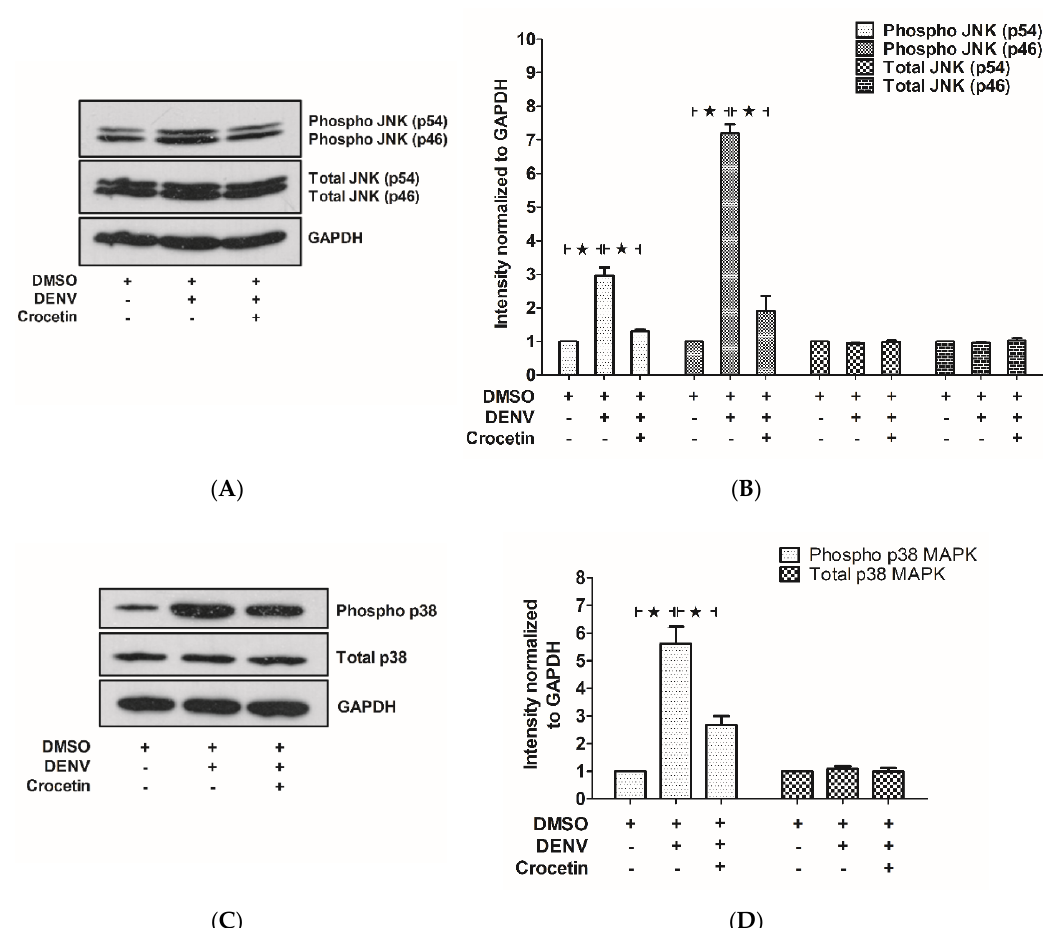
Figure 7. Crocetin reduced the phosphorylation of JNK and p38 in the livers of DENV-infected mice. BALB / c mice were infected with DENV-2 (4 × 10 5 FFU / mL) and then treated with crocetin (50 mg / kg) dissolved in 2% DMSO. DENV-infected 2% DMSO-treated and mock-infected 2% DMSO-treated groups of mice were used as positive and negative controls, respectively. Protein samples were prepared from liver tissues, and then Western blot analysis was performed with normalization to that of GAPDH. Densitometry analysis of blots was conducted using ImageJ software normalized to individual GAPDH. ( A ) Western blot analysis of phosphorylated and total JNK expressions. ( B ) Densitometry analysis of phosphorylated and total JNK expressions. ( C ) Western blot analysis of phosphorylated and total p38 MAPK expressions. ( D ) Densitometry analysis of phosphorylated and total p38 MAPK expressions. The black star represents, those groups were compared and found to be significant.